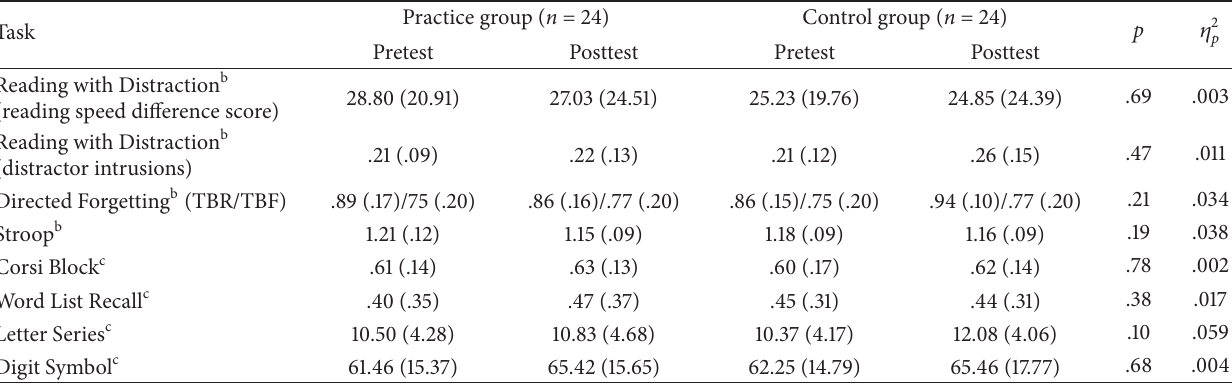
Table 3: Performance on the near-far and far-far transfer tasks.